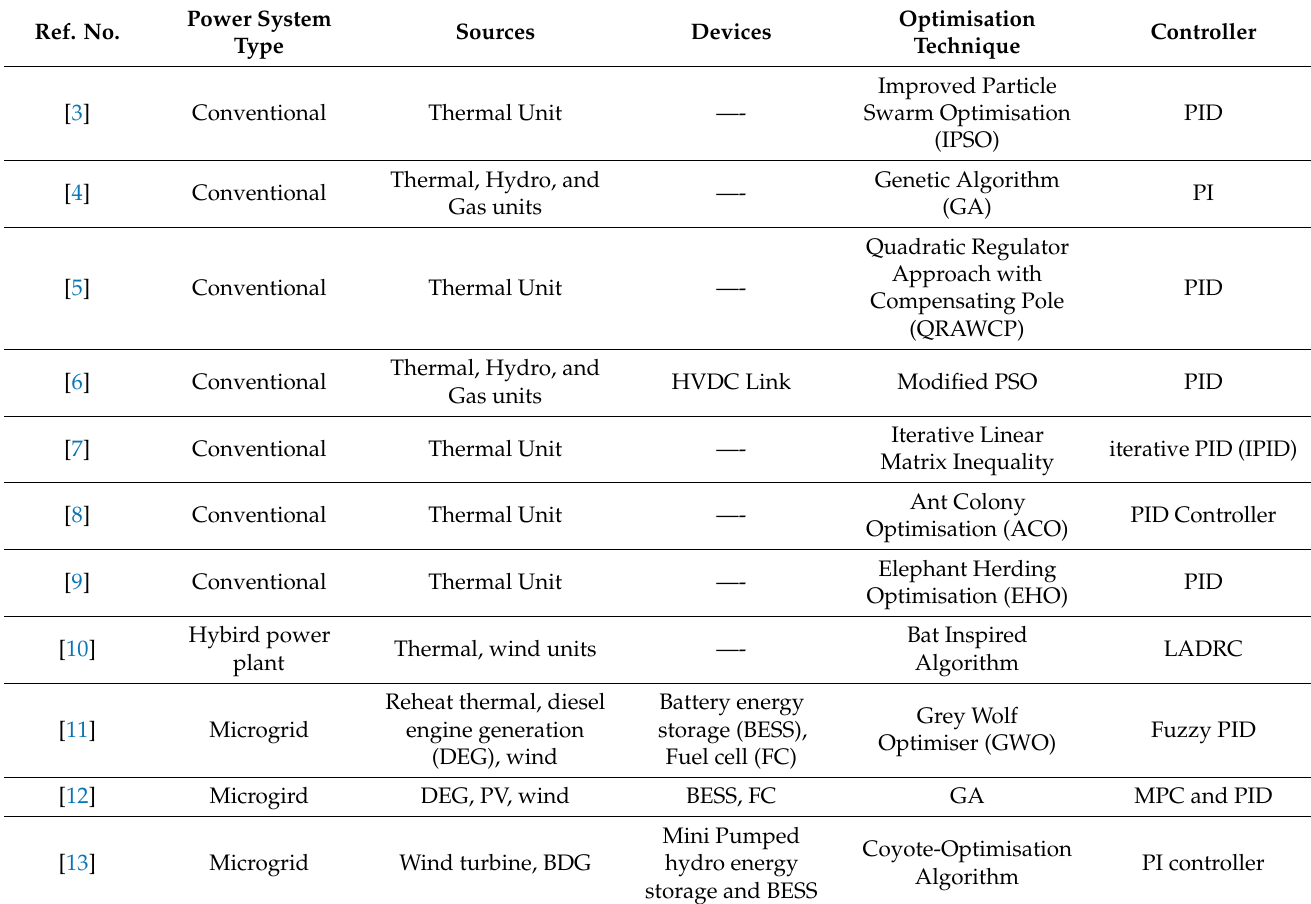
Table 2. Comparison of latest control strategy applied for LFC in the single-area power system. Ref.